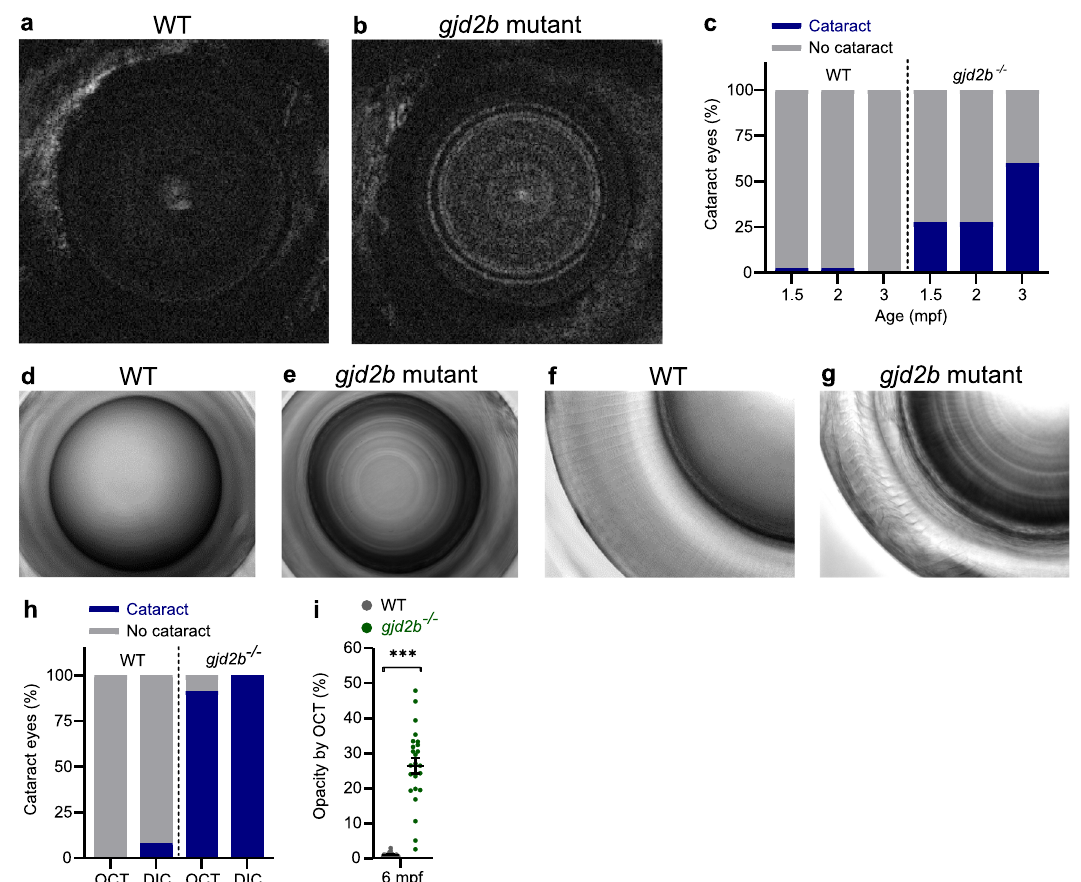
Fig. 3 Nuclear cataract in gjd2b (Cx35.1) mutants. a , b Coronal SD-OCT sections of typical 3 mpf lenses of WT control ( a ) and gjd2b (Cx35.1) mutant ( b ) fi sh. c Proportion of cataractous lenses in 1.5 mpf, 2 mpf, and 3 mpf SD-OCT data ( n = 40 eyes) indicating an increasing prevalence in gjd2b (Cx35.1) mutants. d – g DIC microscopy of 6 mpf fi sh lenses allows visualization of opaque nuclear lens fi bers in lenses of gjd2b (Cx35.1) mutants ( e ) and ( g ) and transparent WT control lenses ( d ) and ( f ). d , e DIC 20× magni fi cation ( f ) and ( g ) 40× magni fi cation. h Proportion of cataractous lenses by SD-OCT and DIC microscopy at 6 mpf ( n = 24 eyes). i Ratio of opaque pixels: total pixels indicating the opacity of 6 mpf coronal SD-OCT sections ( n = 24 eyes). Error bars: SEM. Signi fi cance: ns = not signi fi cant, * p < 0.05, ** p < 0.01, *** p < 0.001. DIC microscopy: differential interference contrast